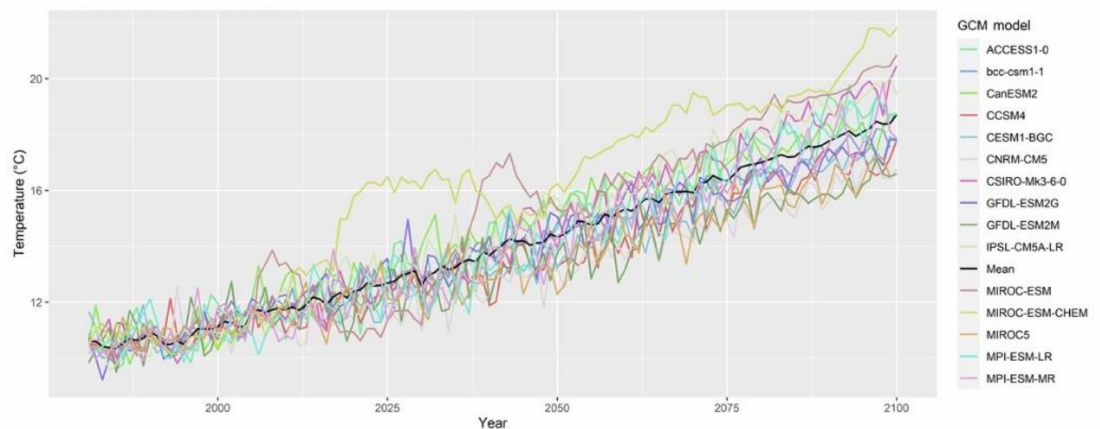
Figure 21. Minimum annual average temperature simulated by climate models, corrected and scaled for the Devil’s Creek, 1981–2100 term, RCP8.5 emission scenario. The black line represents the averaged ensemble of the 15